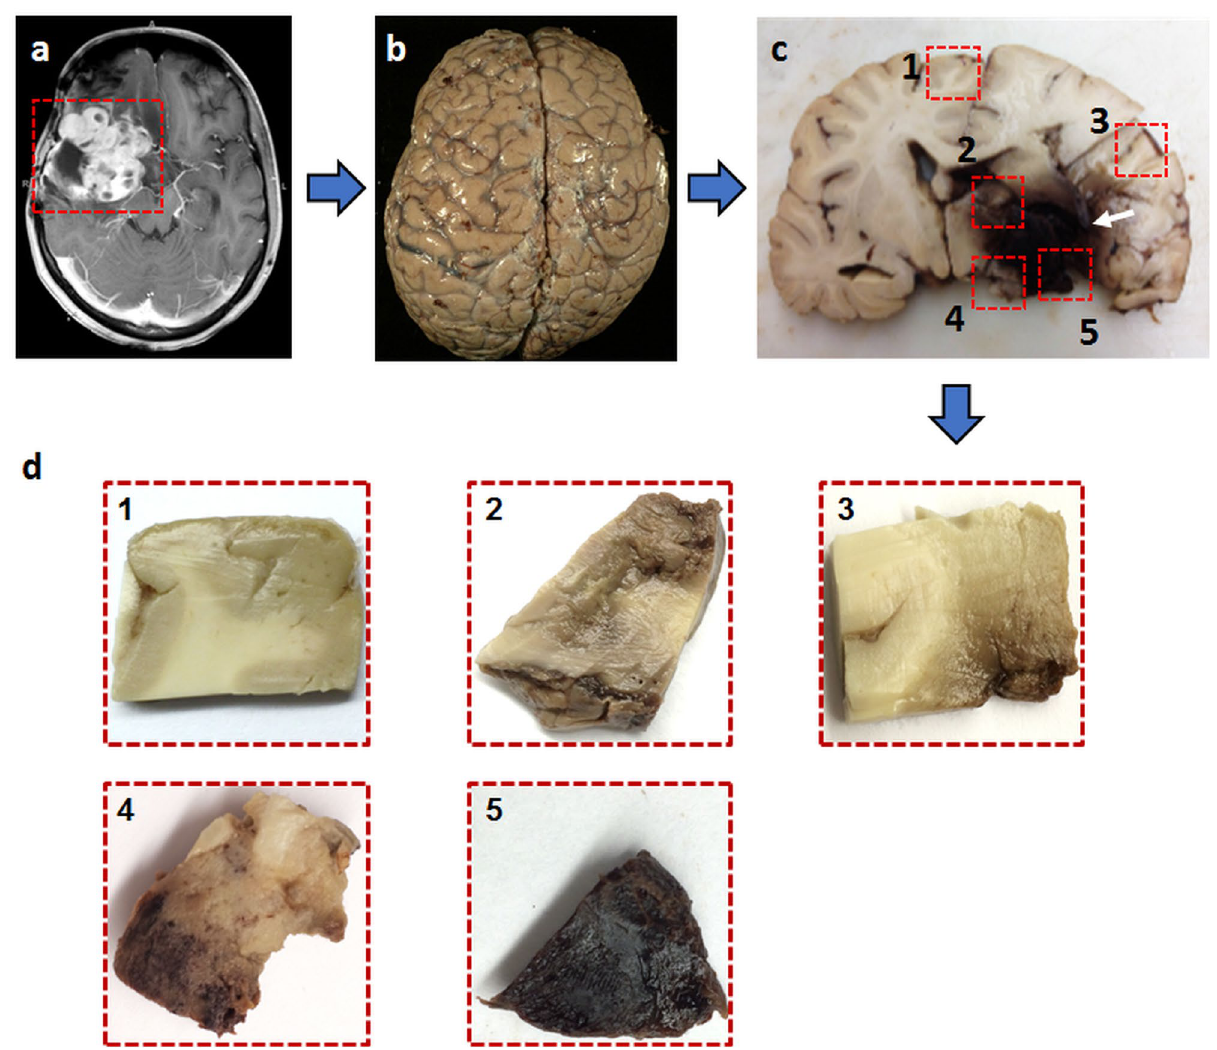
Figure 1. Illustration of brain specimen procurement from a patient with high-grade pediatric brain tumor. ( a ) In vivo Gd-enhanced T1-weighted image indicated a large lesion (square) with heterogeneous intensities in the right posterior region from a 16-year-old patient with embryonal neoplasm (WHO Grade IV). ( b ) Brain specimen was procured and immediately formalin-fixed. ( c ) Coronal slices revealed a large tumor with admixed hemorrhage and necrosis in the right thalamus (arrow). ( d ) Five tissue blocks were prepared in total i.e. from tumor (block 2, blcok 4), tumor interface with normal adjacent brain (block 3), hemorrhage and necrosis (block 5), as well as grossly normal brain (block 1) ( c